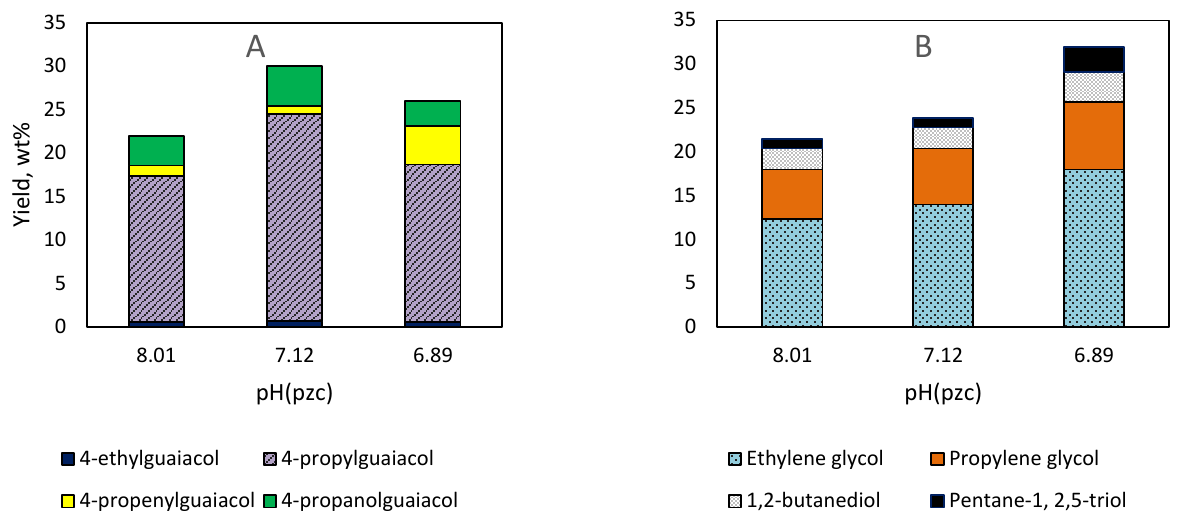
Figure 13. The effect of pH (pzc) of the catalysts on the yields of phenolic monomers ( A ) and polyols ( B ) at spruce wood RCF at 225 ° С for 3 h.